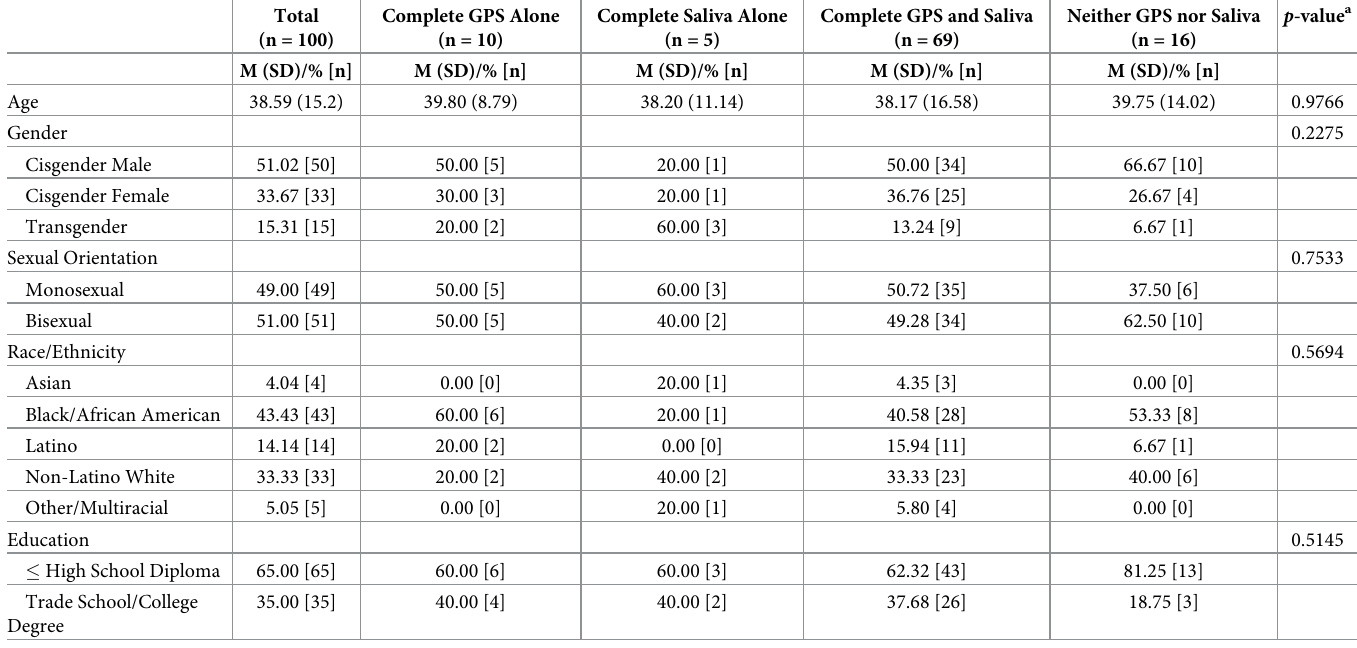
Table 2. Characteristics of participants by different types of data completion on participants providing entire 6 saliva samples without directions violated.